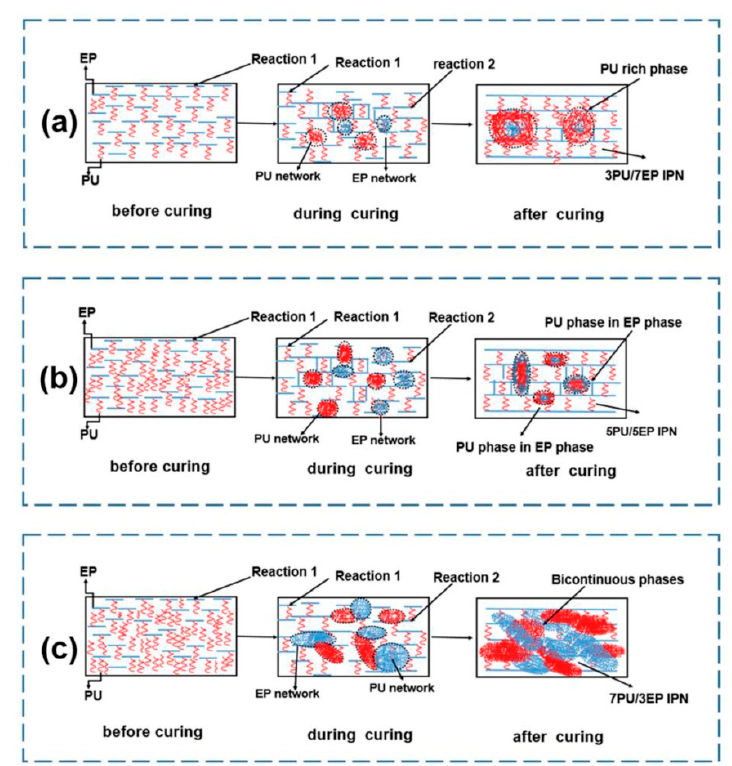
Figure 5. Schematic representation of structural development in epoxy/PU systems with ( a ) 30 wt % PU, ( b ) 50 wt % PU and ( c ) 70 wt % PU. Reaction 1: grafting reaction between -NCO groups of PU and side -OH groups of epoxy (before adding curing agent); Reaction 2: reaction between -NCO groups of PU network and -OH groups of epoxy network (after adding curing agent). Reprinted with permission from ref. [50], Copyright [2019], Elsevier.